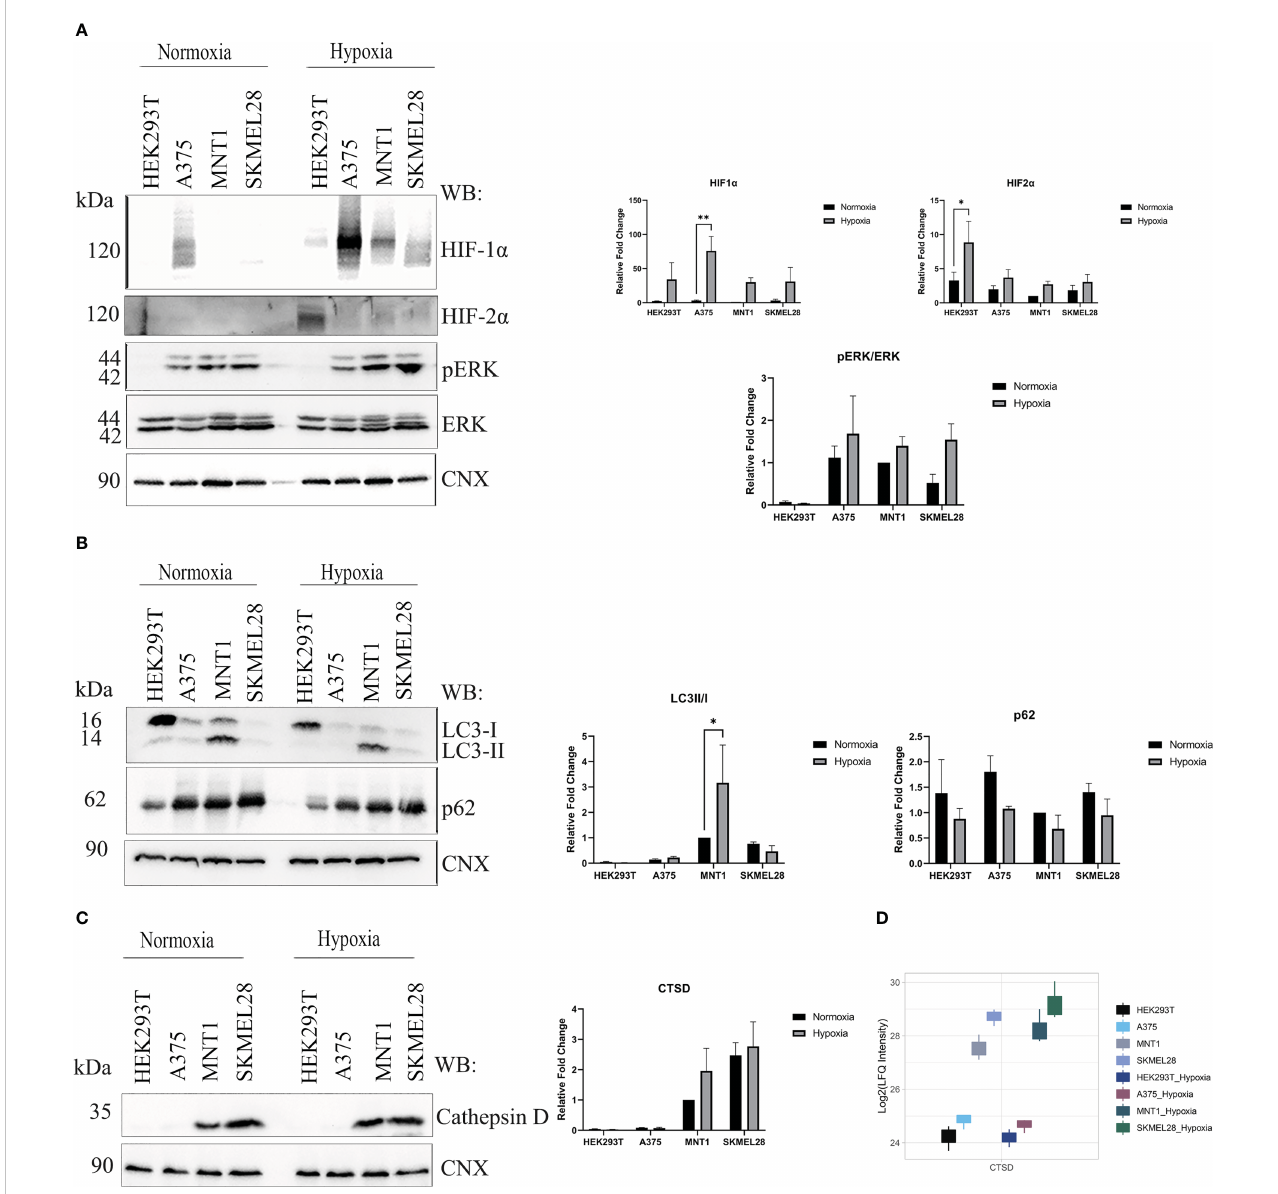
FIGURE 4 Hypoxia in fl uence on several processes upon melanoma cells cultivation under low oxygen condition (1% O 2 , 5%CO 2 and 94% N 2 ). (A) Western blot assay of hypoxia-inducible factor 1-alpha (HIF1 a ), hypoxia-inducible factor 2-alpha (HIF2 a ), phosphorylated extracellular signal-regulated kinase (p-ERK) and extracellular signal-regulated kinases (ERK) protein expressions in HEK293T, A375, MNT1 and SKMEL28 cells. HEK293T, A375, MNT1 and SKMEL28 cells were kept in normoxia and hypoxia (1% O2) for 24 hours, at 37°C. Cells were harvested in RIPA buffer and speci fi c proteins were identi fi ed. Expression levels of HIF1 a and HIF2 a proteins were normalized to calnexin (n=3). (B) Western blotting of autophagy related proteins (LC3 and p62). Quantitative analysis of LC3-II to LC3-I protein ratio, (n=3). (C) The same experiment as in (A) was performed for cathepsin D protein expression. Densitometric quanti fi cation of cathepsin D protein bands was assessed using calnexin as internal control. Data are represented as mean ± SEM (two- way ANOVA with Sidak multiple comparisons test; **p < 0.01, *p < 0.05). (D) Box plot of log2 transformed LFQ intensity values of cathepsin D in normoxia and hypoxia, as emerge from mass spectrometry data